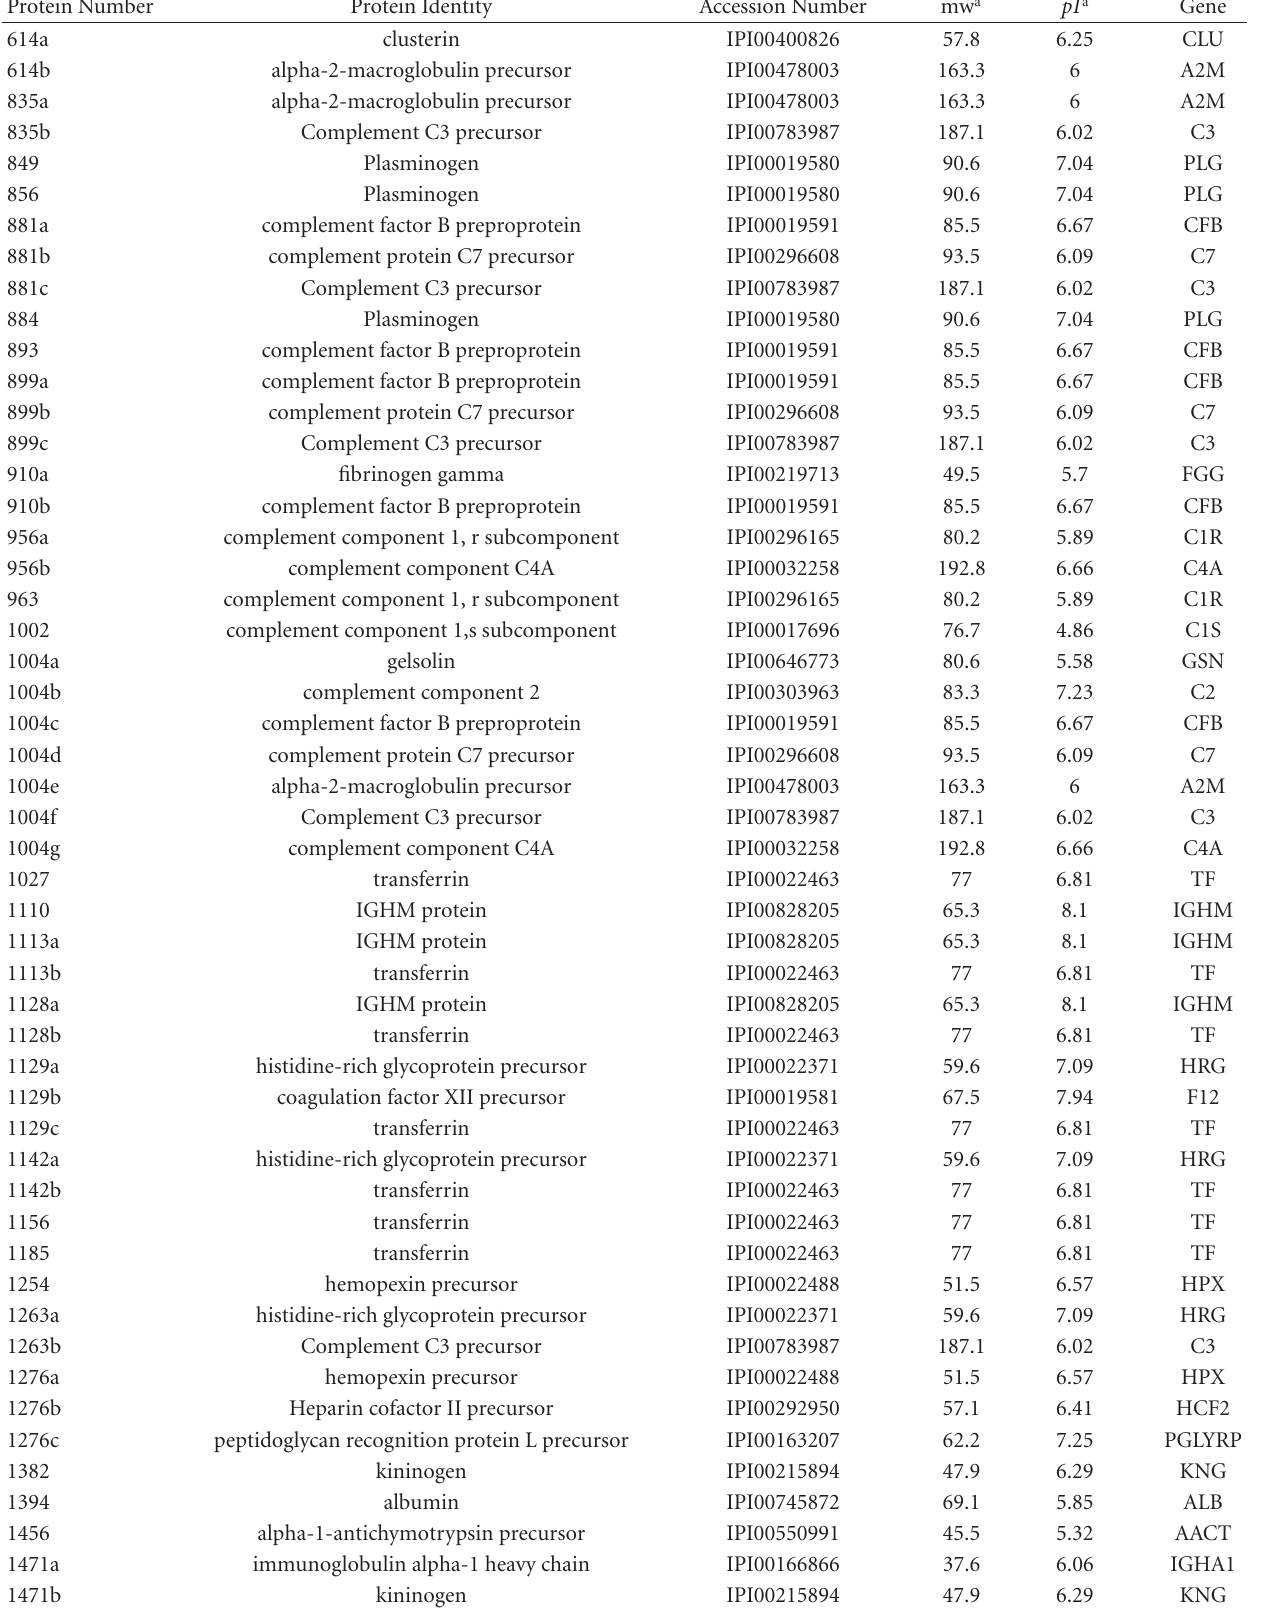
Table 2: Variable proteins identified from human